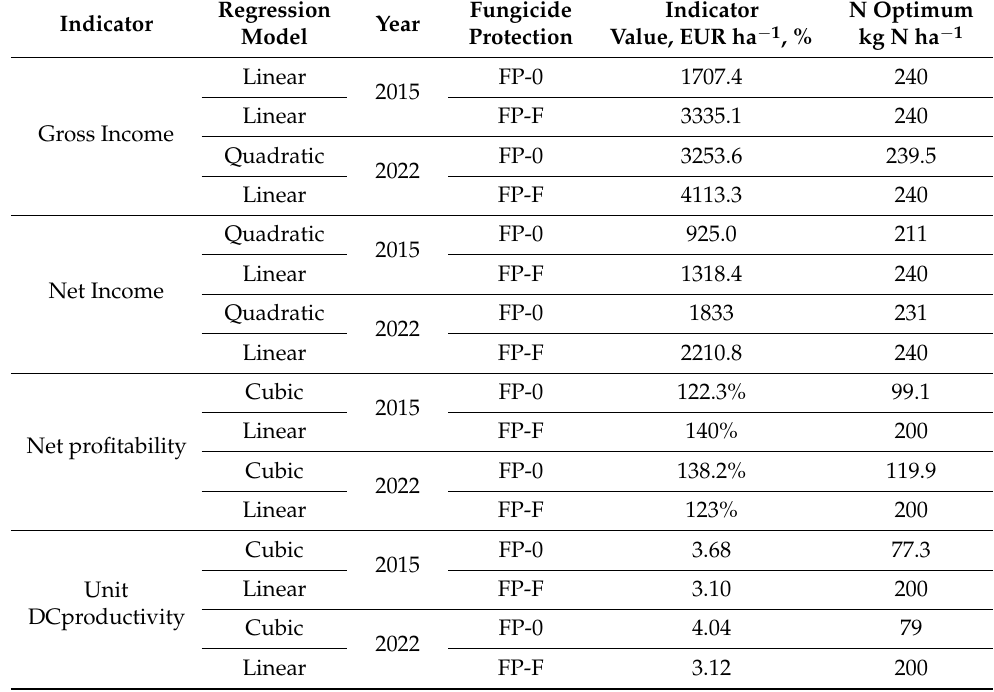
Table A5. Comparative analysis of selected economic indicators of winter wheat production in 2015 and